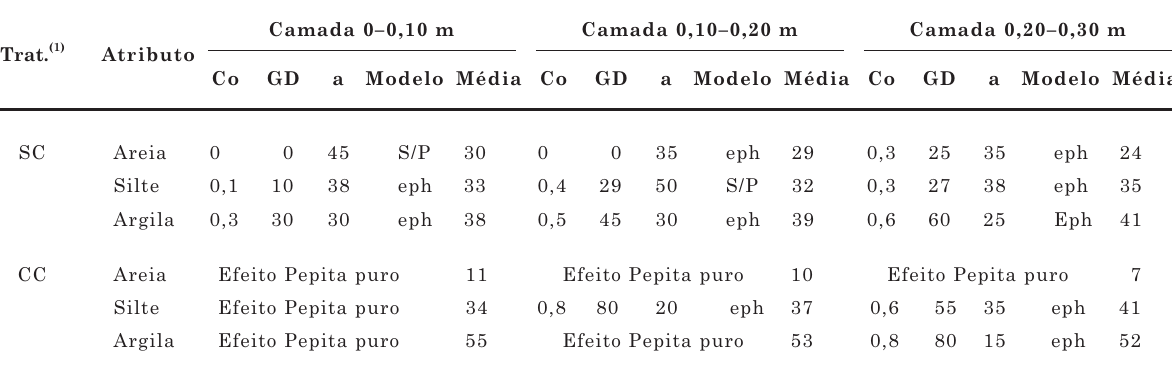
(1) SC: sem cultivo; CC: cultivo contínuo; Co: efeito pepita; a: alcance (em metros); S/P: sem patamar; lin: linear; eph: esférico; GD: grau de dependência; médias em %.